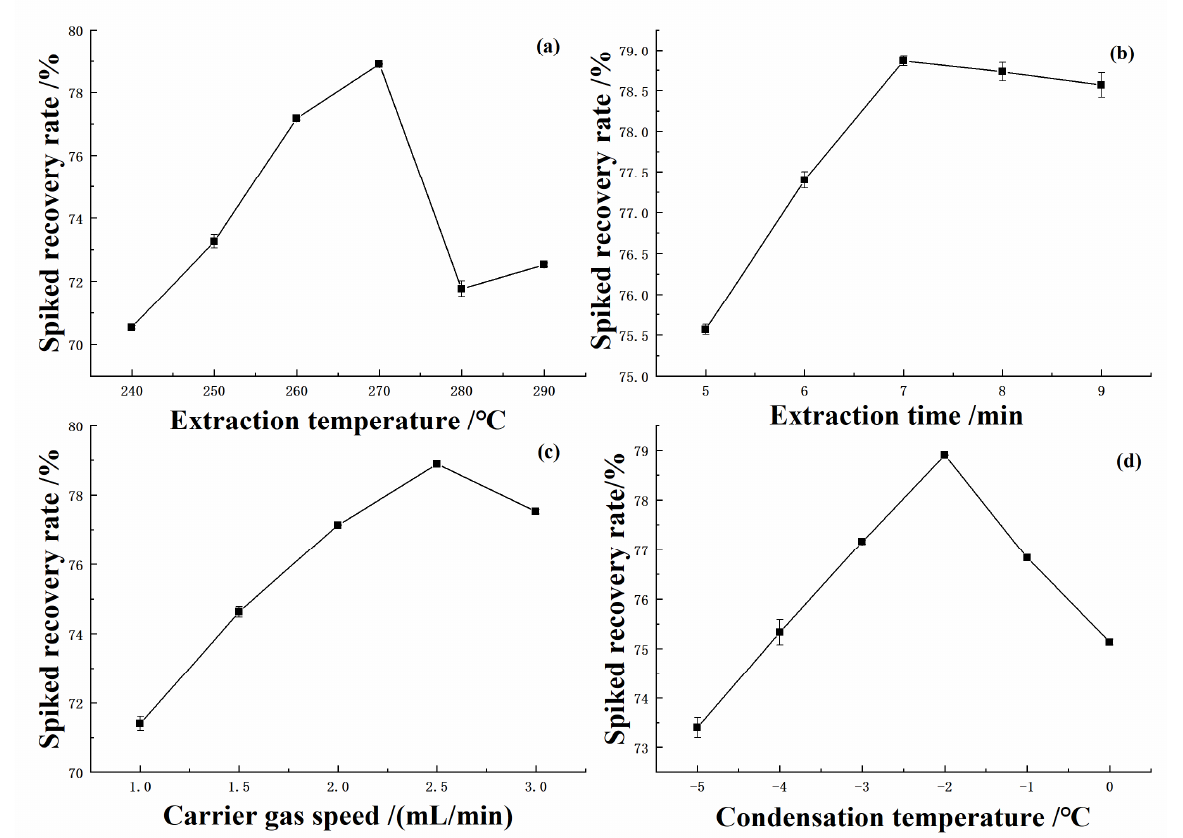
Figure 1. Effect of four factors to spiked recovery rate: extraction temperatures ( a ), extraction time ( b ), carrier gas speed ( c ), and condensation temperature ( d ).